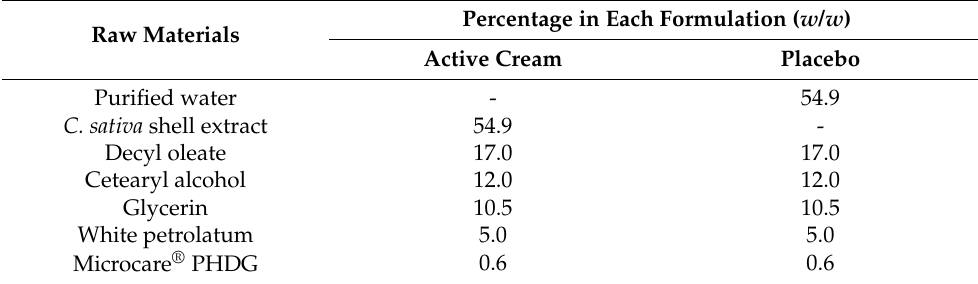
Table 1. Percentage of raw materials present in each formulation (active and placebo). Raw